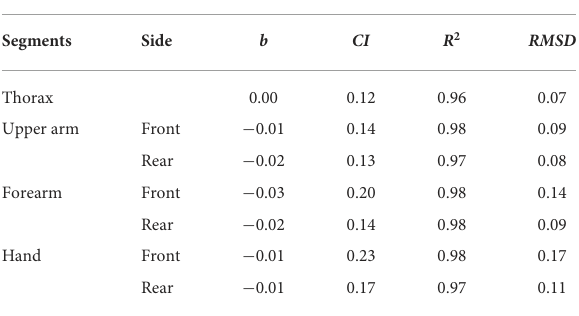
TABLE 4 Bland–Altman bias ( b ), confidence interval ( CI ) along with coefficient of determination ( R 2 ) and root mean square difference ( RMSD ) between markerless and marker-based methods for segment velocity magnitudes at the thorax, upper arm, forearm, and